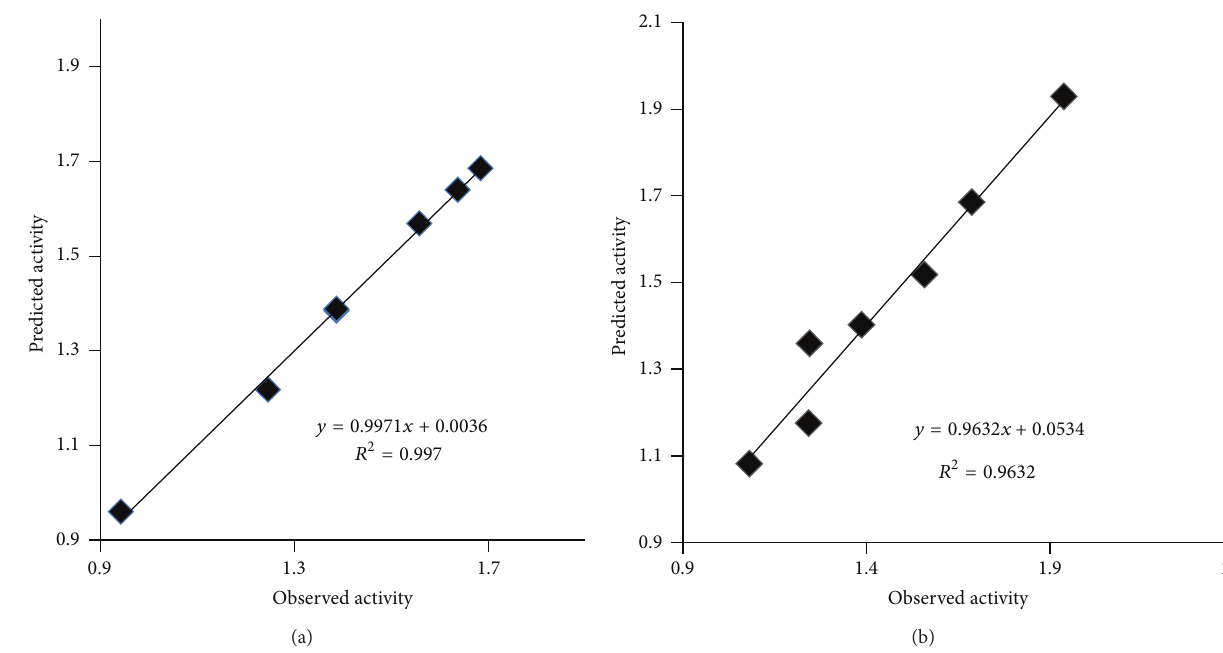
Figure 5: Plot of Predicted pMIC values against observed pMIC for QSAR model for (a) Pseudomonas aeruginosa and (b) Enterococcus faecalis.